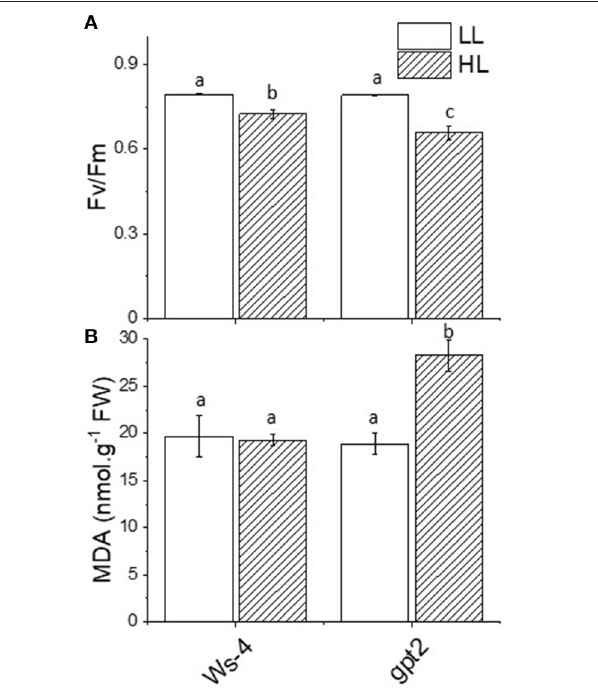
FIGURE 2 | Stress responses in Ws-4 wild type and gpt2 mutant plants. Plants were grown for 7 weeks at an irradiance of 100 µ mol m − 2 s − 1 before either remaining at that irradiance (LL) or being transferred to 400- µ mol m − 2 s − 1 (HL) conditions for 7 more days. (A) Maximum quantum yield of Photosystem II (F v /F m ). Prior to the measurement, the plants were removed from the growth conditions and dark-adapted for 30min. (B) Production of the malondialdehyde equivalent level (nmol g − 1 FW). Samples were harvested directly from growth conditions at mid-day on Day 7 of the treatment and flash-frozen in liquid N 2 . A two-way ANOVA followed by a Tukey’s post-hoc test were used to test the significance between means. Significantly different values are indicated by different lowercase letters at p ≤ 0.05. Factorial analysis shows that both light and genotype factors are significant at p ≤ 0.05. under growth conditions and assayed for anthocyanin